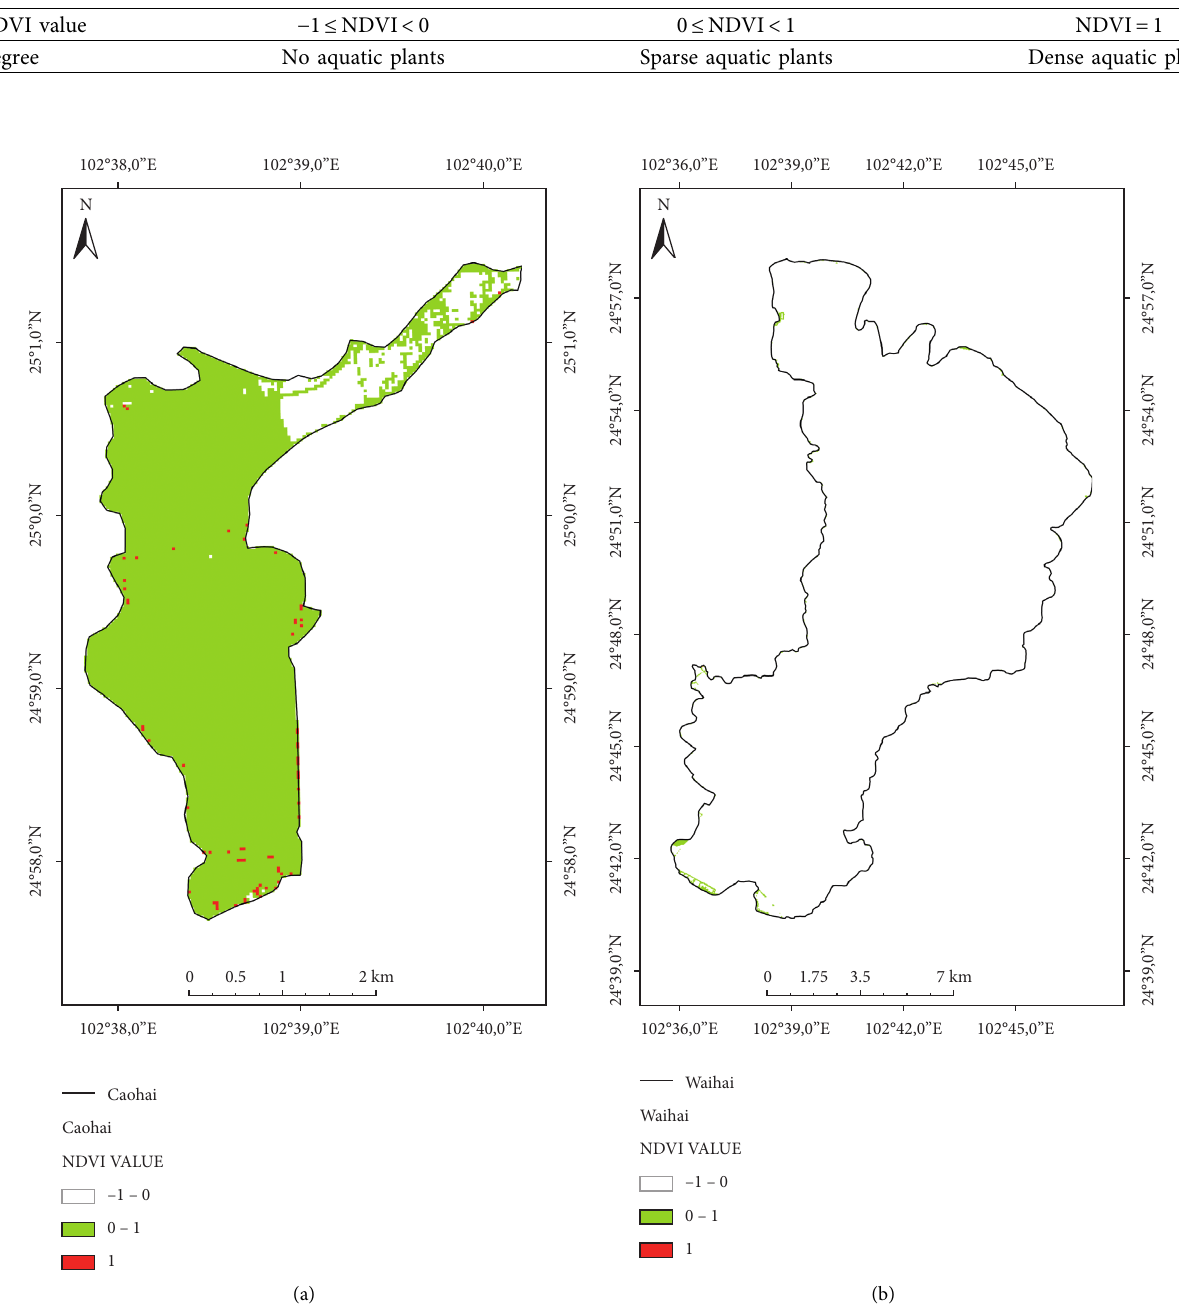
Table 6: NDVI threshold division standard.